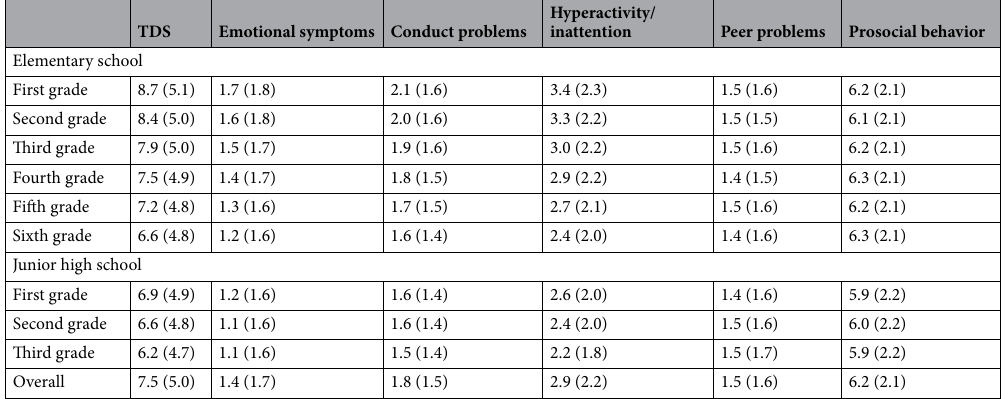
Table 3. Strengths and difficulties questionnaire by school grade. Continuous variables are expressed as the mean ± standard deviation. TDS total difficulty score.